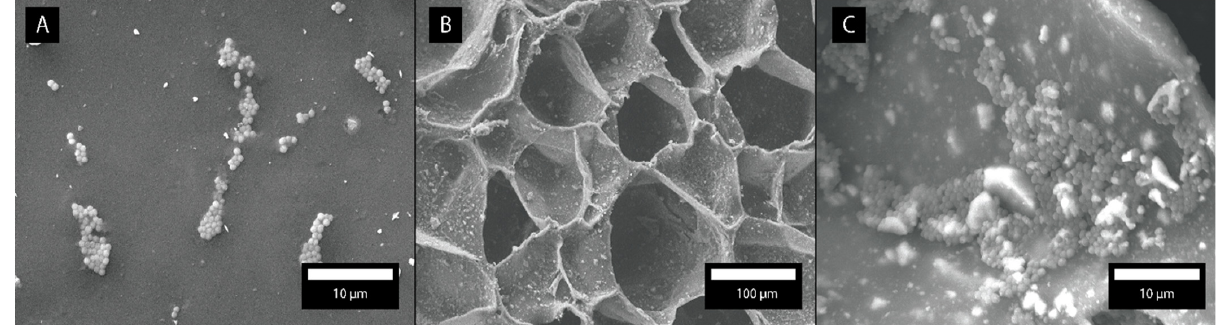
Figure 6. SEM micrographs of ( A ) EVA flat surface with bacteria forming small flakes around asperities. PE and cork samples have similar honeycomb structure ( B ). Bacteria are mostly adhered to the well walls in the form of closely packed films ( C ).